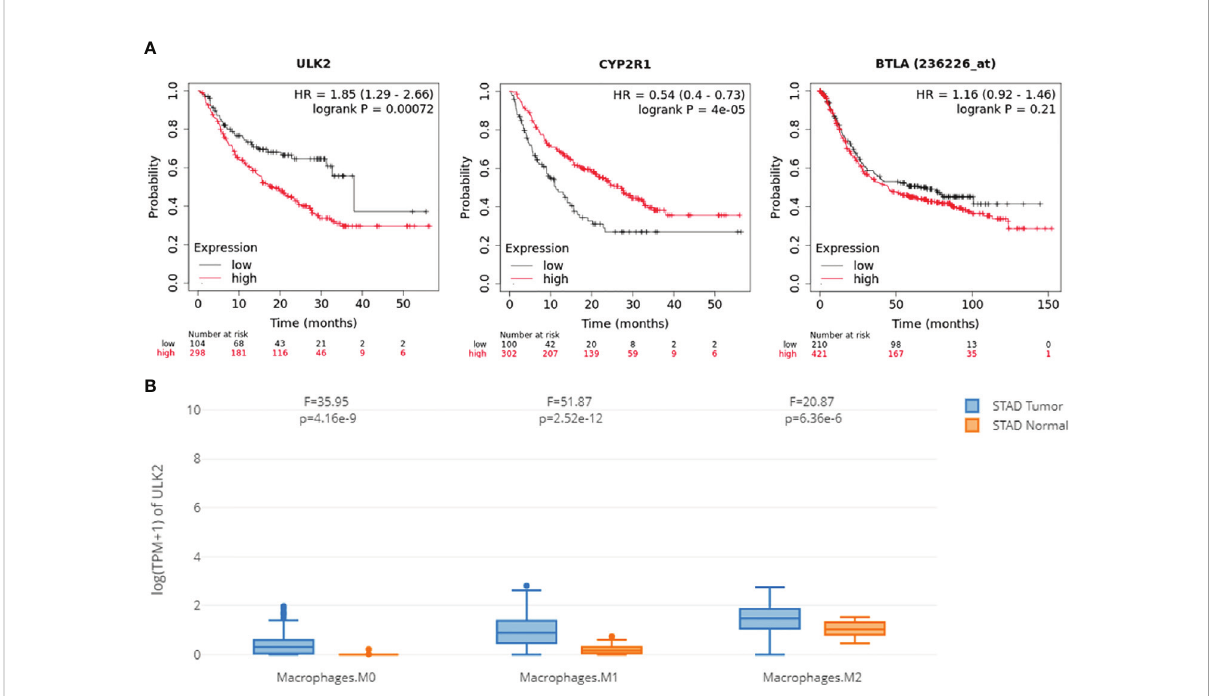
FIGURE 7 ceRNA network hub genes ULK2, CYP2R1, and BTLA are prognostic in the immunotherapy cohort. (A) The three genes can separate patients with long and short survival time from patients with anti-PD-1 treatment. (B) Macrophages have signi fi cant differential expression when comparing ULK2 between normal and tumor